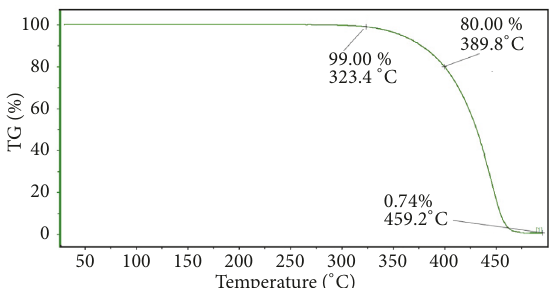
Figure 7: TG curves of PP powders.